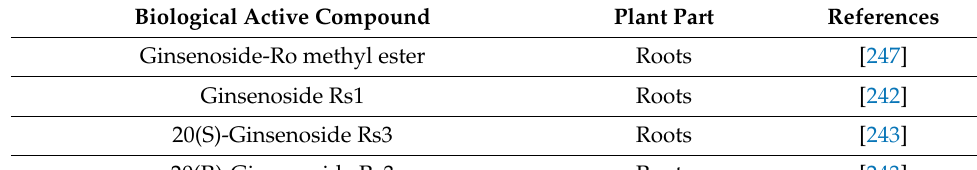
Table 5. Cont. Biological Active Compound Plant